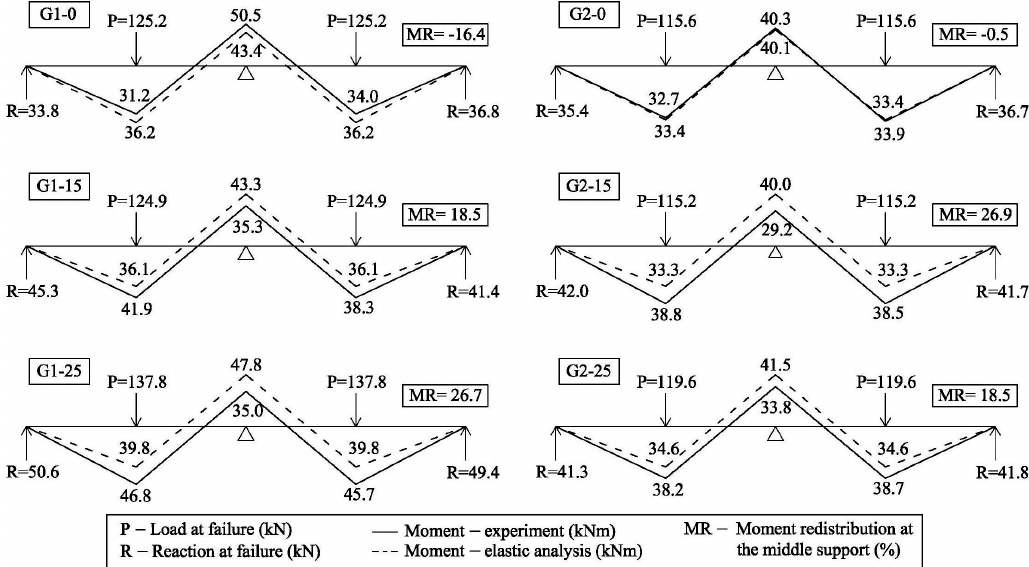
Figure 5. Modes of failure of experimental beams.